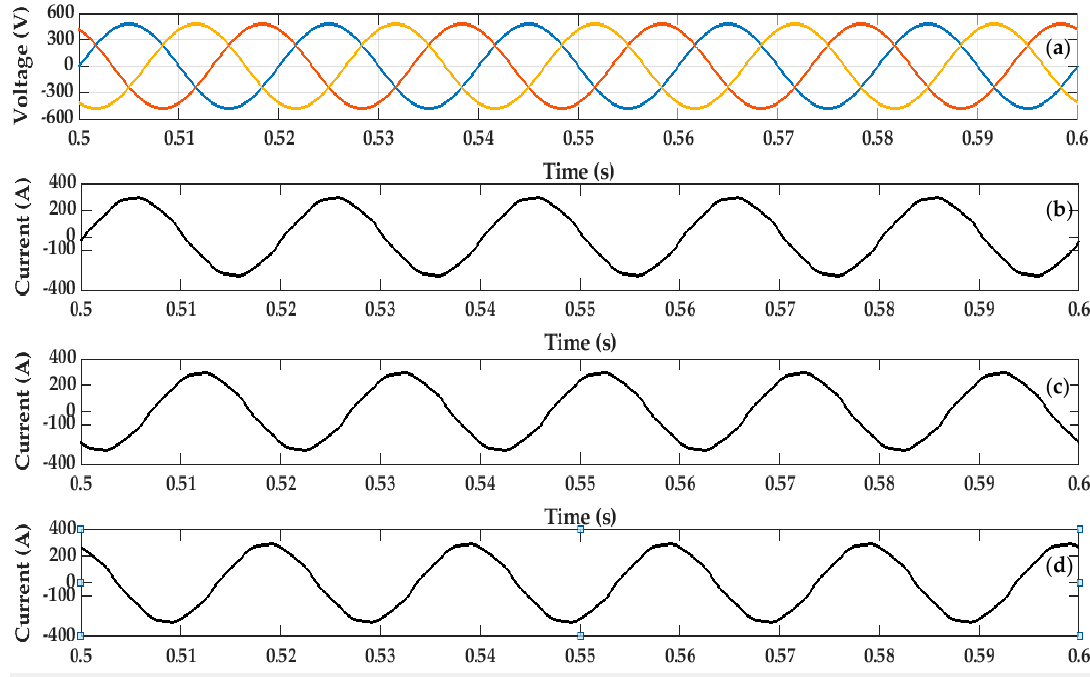
Figure 9. The waveforms of three-phase input voltages along with input currents: ( a ) input three-phase voltages, ( b ) input current (phase A), ( c ) input current (phase B), ( d ) input current (phase C).